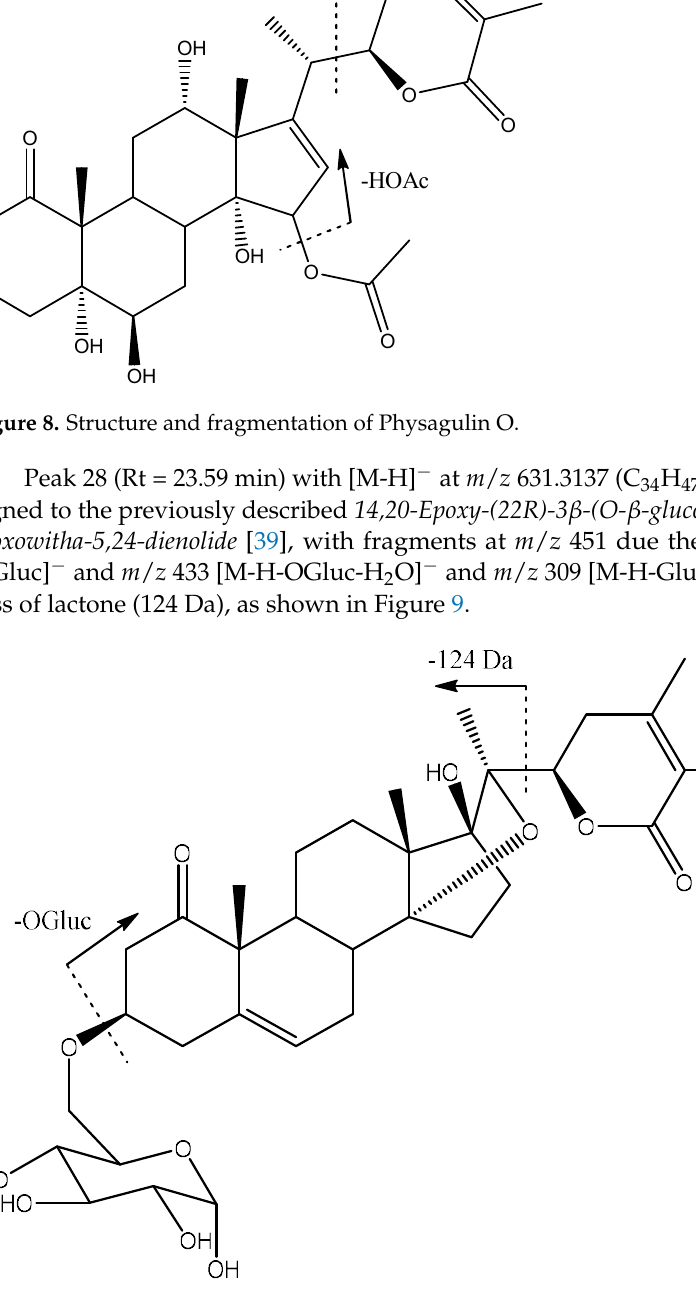
Figure 9. 14,20-Epoxy-(22R)-3 β -(O- β -glucopyranosyl)-17 β -hydroxy-1-oxowitha-5,24-dienolide structure and fragmentation. Finally, peaks 23 (Rt = 22.51 min) and 30 (Rt = 23.66 min), with [M-H] − at m / z 661.3590 (C 36 H 53 O 11 ), and peak 57 (Rt = 39.17 min), with [M-H] − at m / z 649.3606 (C 35 H 53 O 11 ), were tentatively assigned to previously described Physalolactone B-3-O- β -glucopyranoside isomers [32] and Daturafosilide B [40], with a common fragmentation pattern due to the loss of glucose-yielding fragments at m / z 481 and m / z 469 [M-H-OGluc] − , respectively, and the loss of their lactone moieties ( − 124 and − 140 Da) yielding fragments at m / z 357 and m / z 329, respectively (Figure